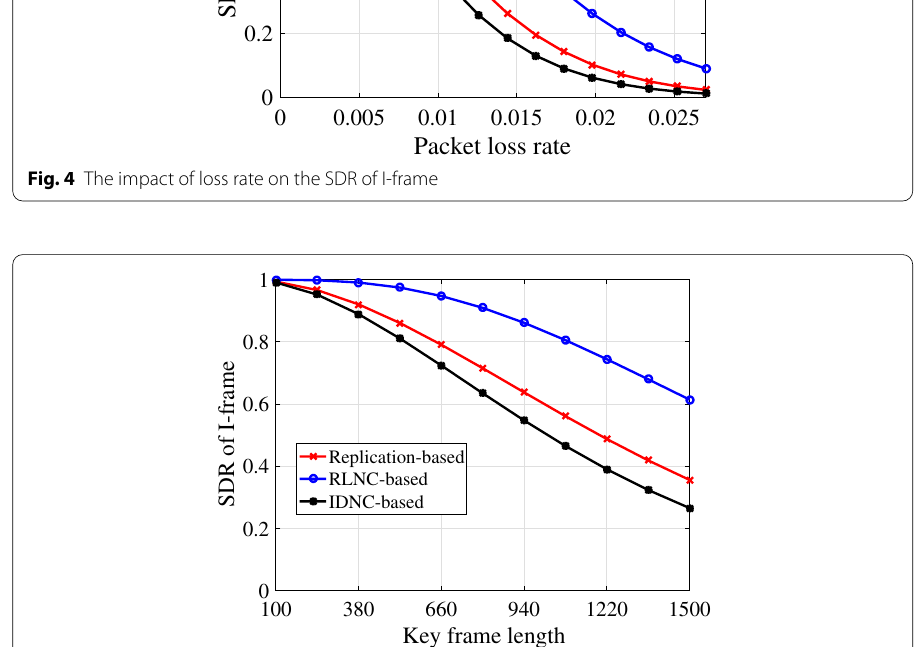
Fig. 5 The impact of length on the SDR of